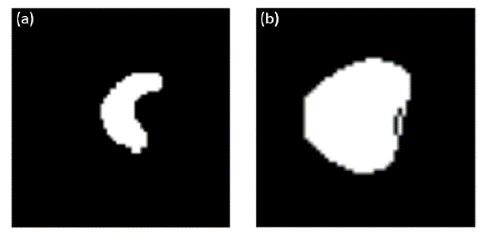
Fig. 6. The result of segmentation using adaptive threshold (a), convex hull (b), and morphological opening